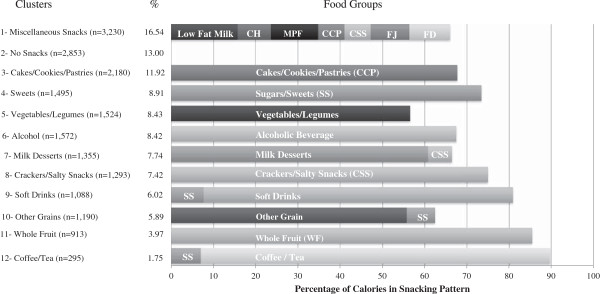
Description of the twelve snacking pattern clusters in adults ≥19 years of age. Reference group is Cluster Pattern #2 - No Snacks (n = 2853, 13%). SS = Sugars and Sweets; WF = Whole Fruit; CSS = Crackers/Salty Snacks; CH = Cheese; MPF = Meat/Poultry/Fish; CCP = Cakes/Cookies/Pastries; FJ = Fruit Juice; FD = Fruit Drinks.